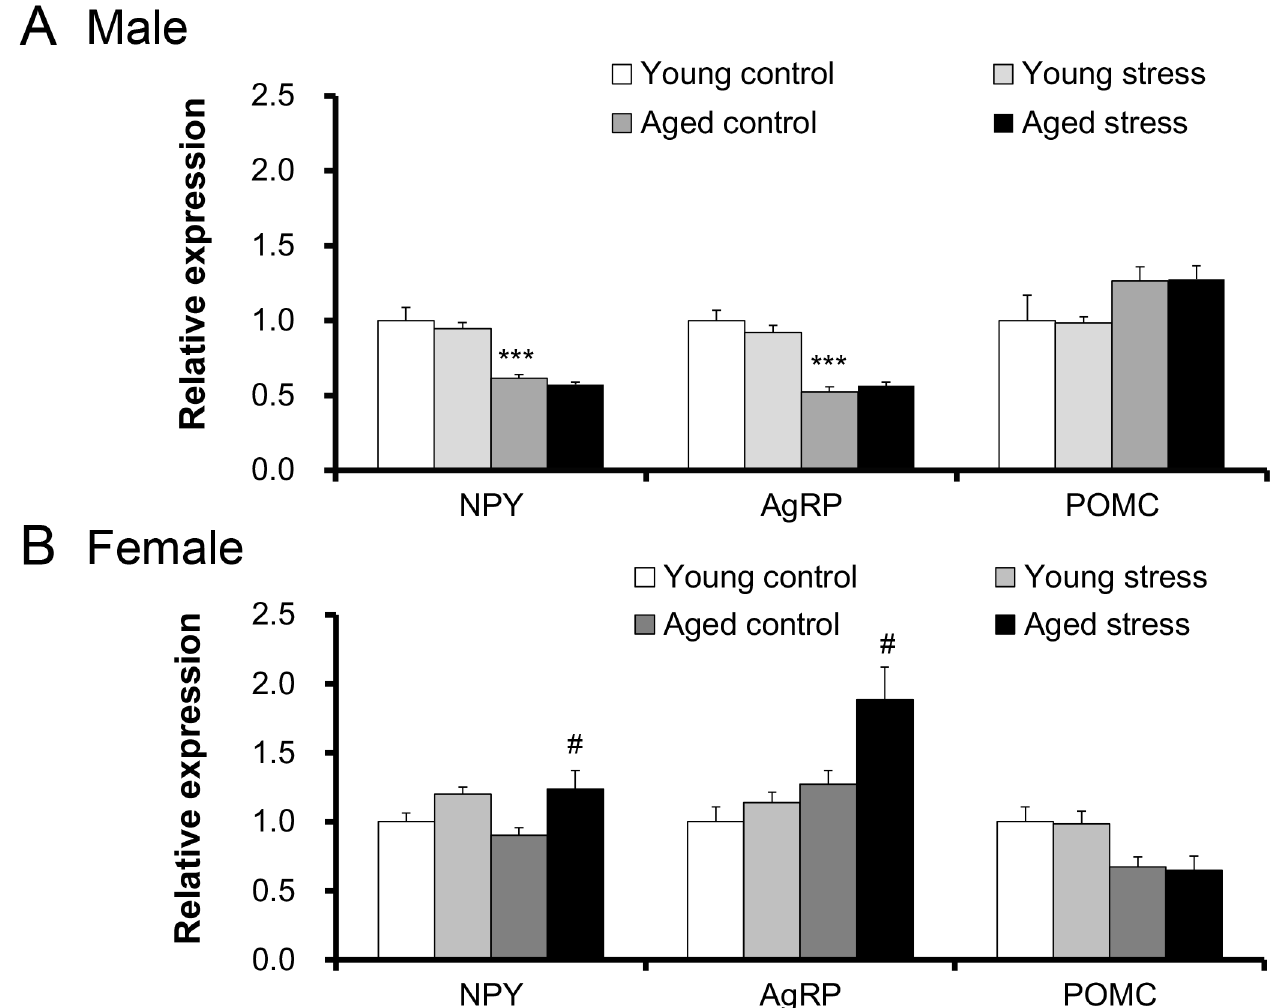
Fig 4. Changes in hypothalamic appetite-related peptide gene expressionin aged male or female mice exposed to novelty stress. The 6 h hypothalamic appetite-related peptidein young and aged male mice (A), or female mice (B) exposedto novelty stress. Data are presentedas the mean ± SEM (young male and aged female groups; n = 8, aged control female group; n = 7). *** , p < 0.001 vs. young control group. #, p < 0.05 vs. aged control group.